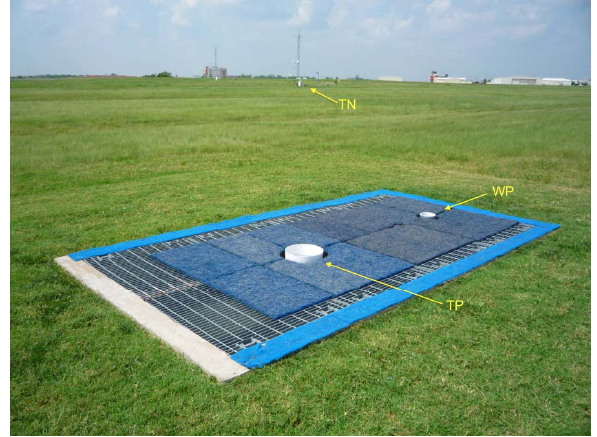
Fig. 1 View of field site looking northwest. In the foreground is the closed pit with Fig. 1. View of field site looking northwest. In the foreground is tipping-bucket gauge TP and weighing-bucket gauge WP; in the background is tipping-bucket gauge TN (not easily discernible, but see Fig. 3) located at the the closed pit with tipping-bucket gauge TP and weighing-bucket Norman Mesonet site. gauge WP; in the background is tipping-bucket gauge TN (not eas- ily discernible, but see Fig. 3) located at the Norman Mesonet site.